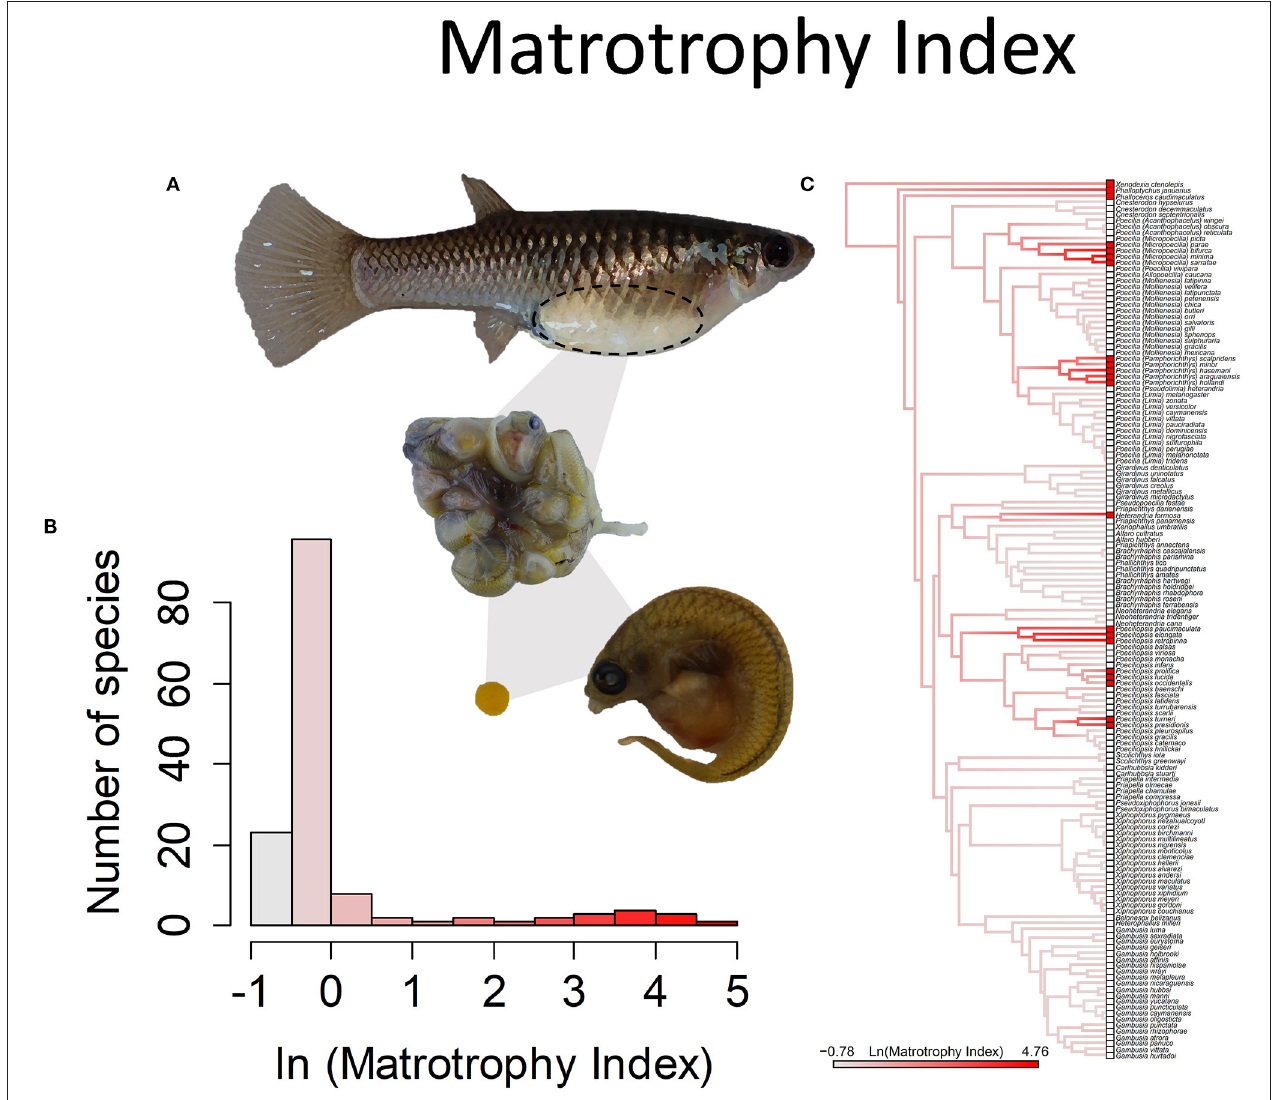
FIGURE 8 | The Matrotrophy Index, measured as the ratio of offspring dry mass at birth to that of a just fertilized embryo, is a unitless measure of the degree of post-fertilization maternal embryo provisioning. In the family Poeciliiidae, this value ranges from 0.46 to 117. Values < 1 indicate embryos lose mass over the course of gestation and are considered lecithotrophic or “yolk feeding” (a value of 0.7 represents the loss of mass in egg-laying species), and larger values indicate matrotrophy or “mother feeding.” (A) Poeciliopsis retropinna is a highly matrotrophic species (Reznick et al., 2002, Hagmayer et al., 2018, Hagmayer et al., 2020). Over the course of gestation in the ovary (pictured), embryos undergo an up to 117-fold increase in dry weight, due to nutrient provisioning by means of a follicular placenta. (B) Frequency histogram of the natural log transformed Matrotrophy Index ( n = 146). (C) Ancestral state reconstruction of the Matrotrophy Index as a continuous character using the contMap function in the R package phytools, which estimates the Maximum likelihood ancestral states at all internal nodes and interpolates the states along each edge. The phylogeny tips depict a binary categorization of the placenta (i.e., absent vs. present). Please note, the reconstruction depicted here omits a basal lineage, Tomeurus gracilis , the sole non-livebearing member of the family, as well as non-livebearing outgroup taxa. A reconstruction of placentation as a binary presence or absence character, with the inclusion of these taxa, suggests the most likely ancestral state of the family is to lack placentation (Furness et al., 2019).